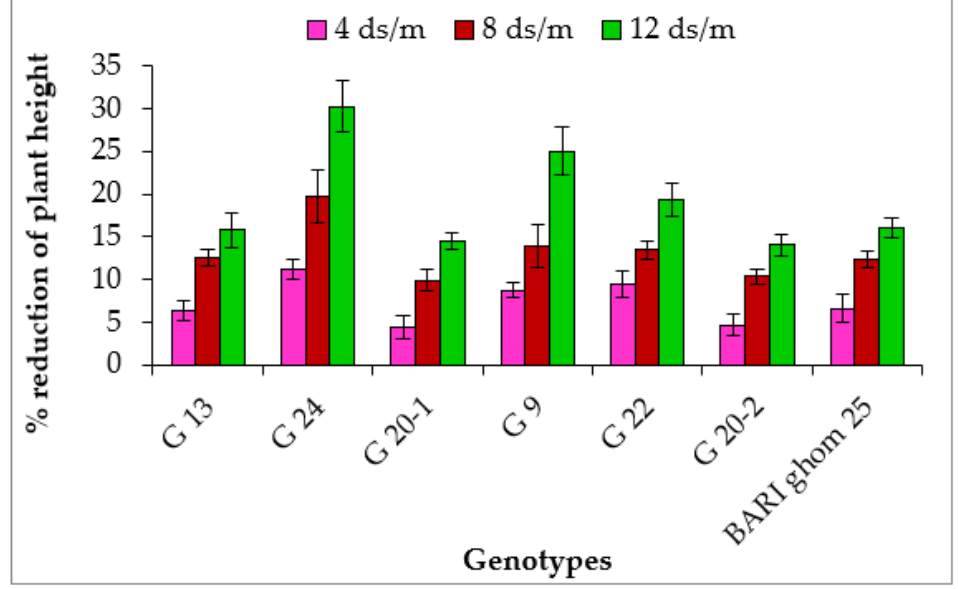
Figure 1. Reduction (%) of plant height of wheat genotypes under various salinity levels. The vertical bar indicates average of five independent replicates ( n = 5). Error bars represent standard error.